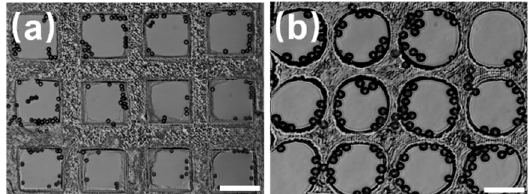
Figure 5. Microspheres captured in shallow arrays of the microwell. The patterns are: ( a ) square and ( b ) circular. Scale bar: 100 μ m.